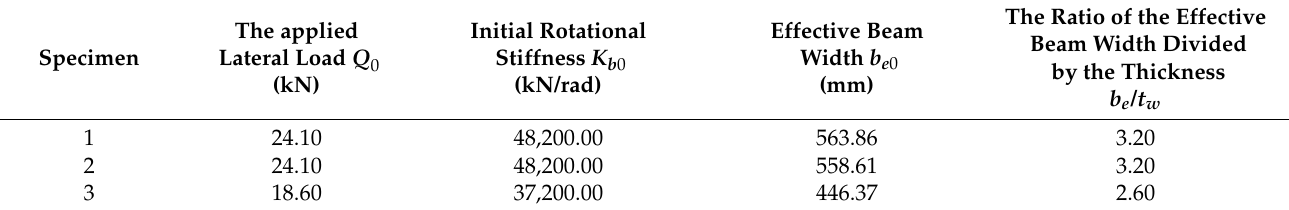
Table 2. Application experimental test results to the proposed